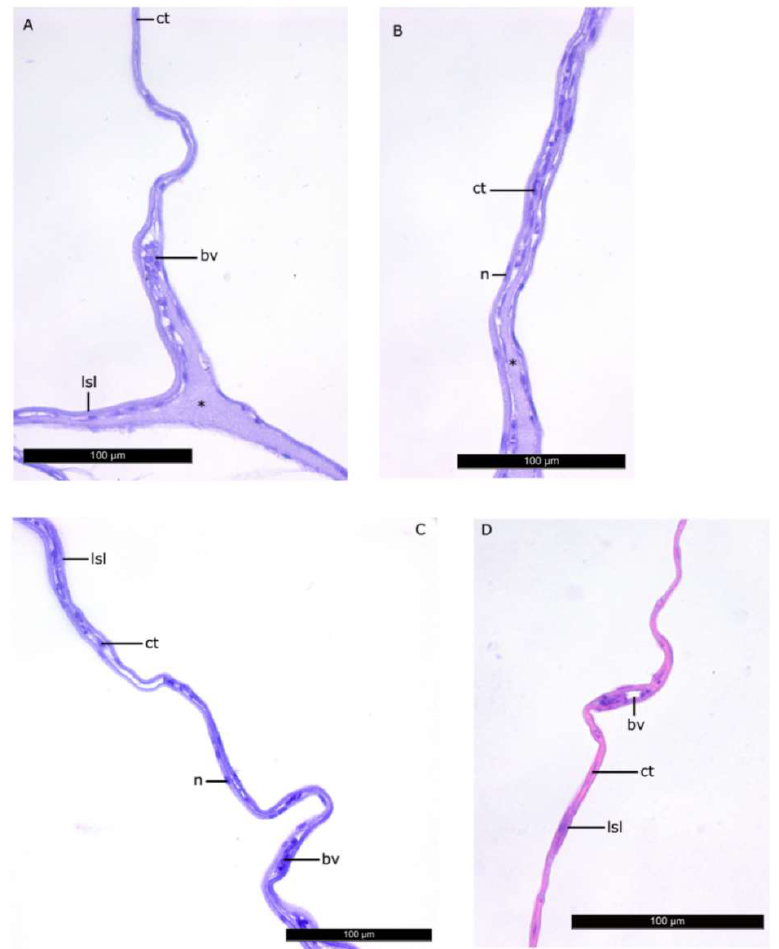
Figure 4. The walls of the lipid sac compartments. Parasagittal sections. ( A – C )—L2 stage, ( D )—L4 * stage. Figure legend: bv—blood vessel, lsl—lipid syncytial layer, ct—connective tissue, n—nucleus of LSL. The homogenous matrix between the compartments of LS. Staining: Carazzi’s hematoxylin and eosin. Bar: 100 µm.